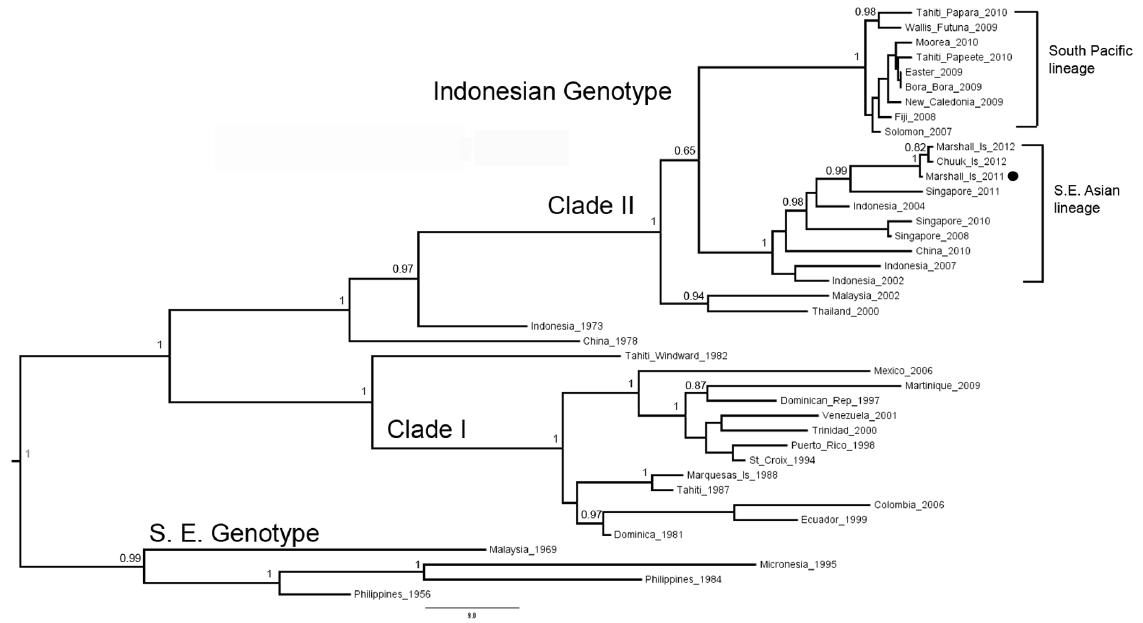
Figure 4. Bayesian maximum clade credibility phylogenetic tree of DENV-4 detected during the 2011–2012 dengue outbreak in the Republic of the Marshall Islands. N=40 E gene sequences (1,485 basepairs). Internal nodes supported by posterior probability. The dot indicates the DENV-4 isolated from the Republic of the Marshall Islands in 2011 (GenBank accession number JX891655).